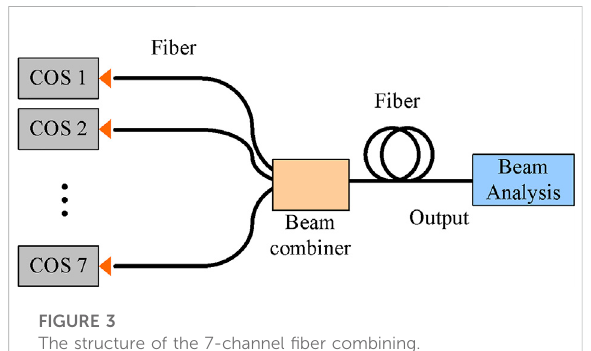
FIGURE 3 The structure of the 7-channel fi ber